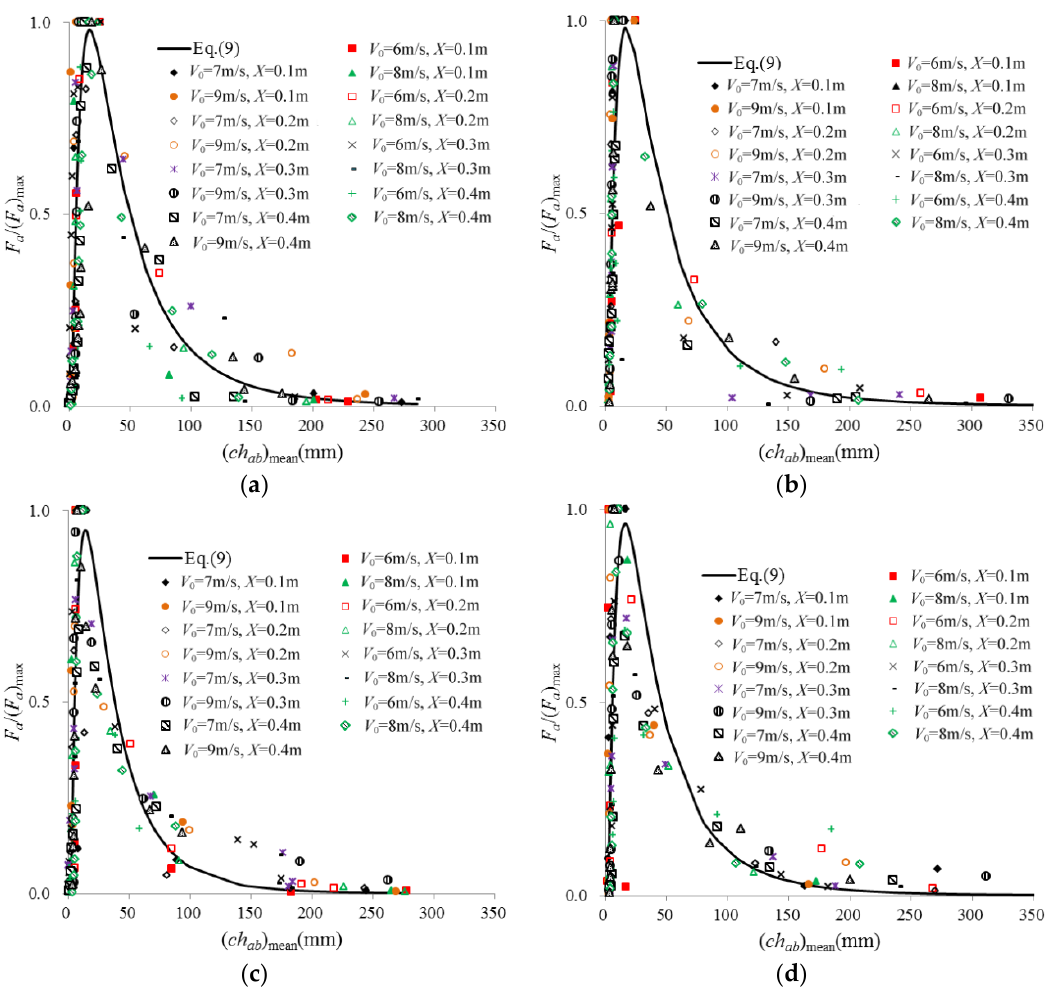
Figure 13. Comparison of experimental data with calculated values of air bubble chord length. ( a ) upper nappe; ( b ) lower nappe; ( c ) side nappe.